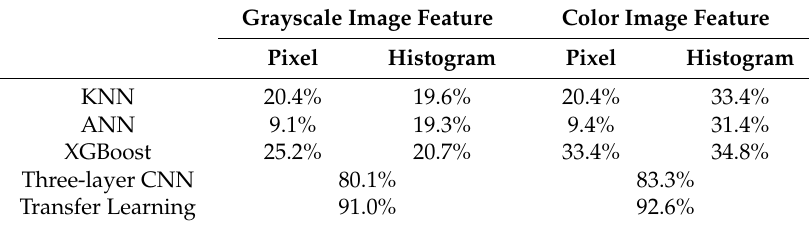
Table 3. Comparison result between the five methods.